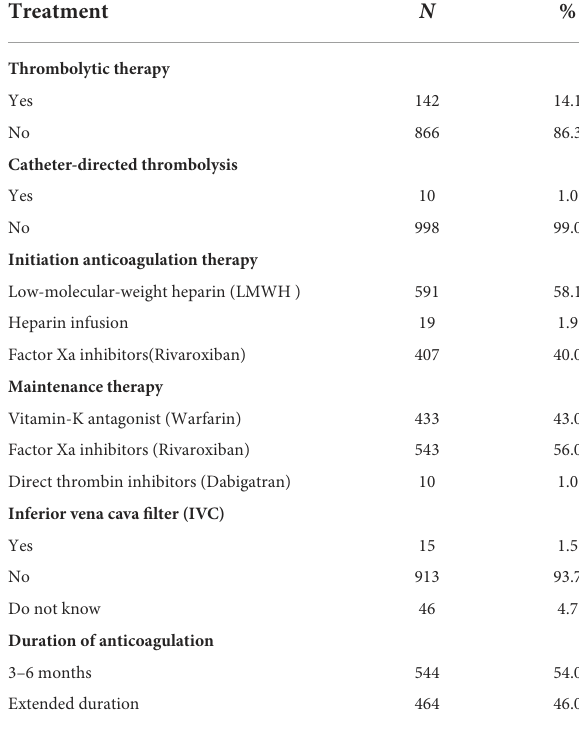
TABLE 3 Management and outcome of the current episode of venous thromboembolism.